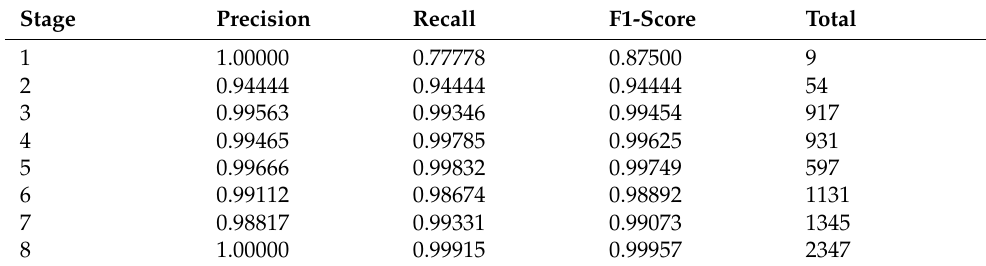
Table 12. The Performance Metrics of the RF Baseline Model for Each